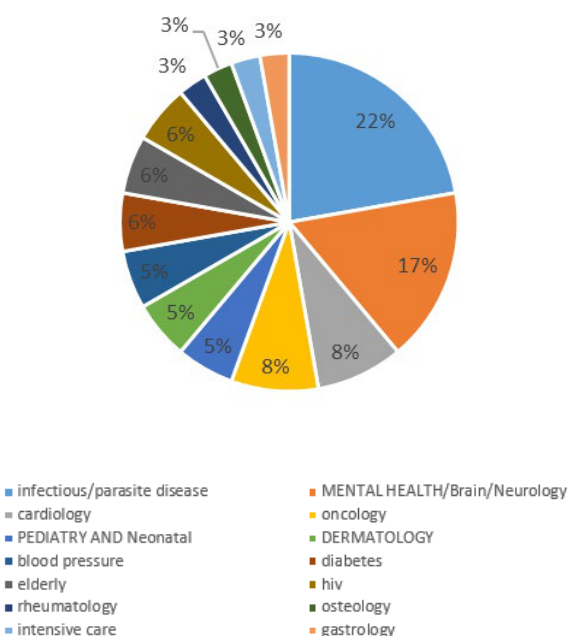
Figure 6. Distribution of real time remote sensing publications per Family of Diseases